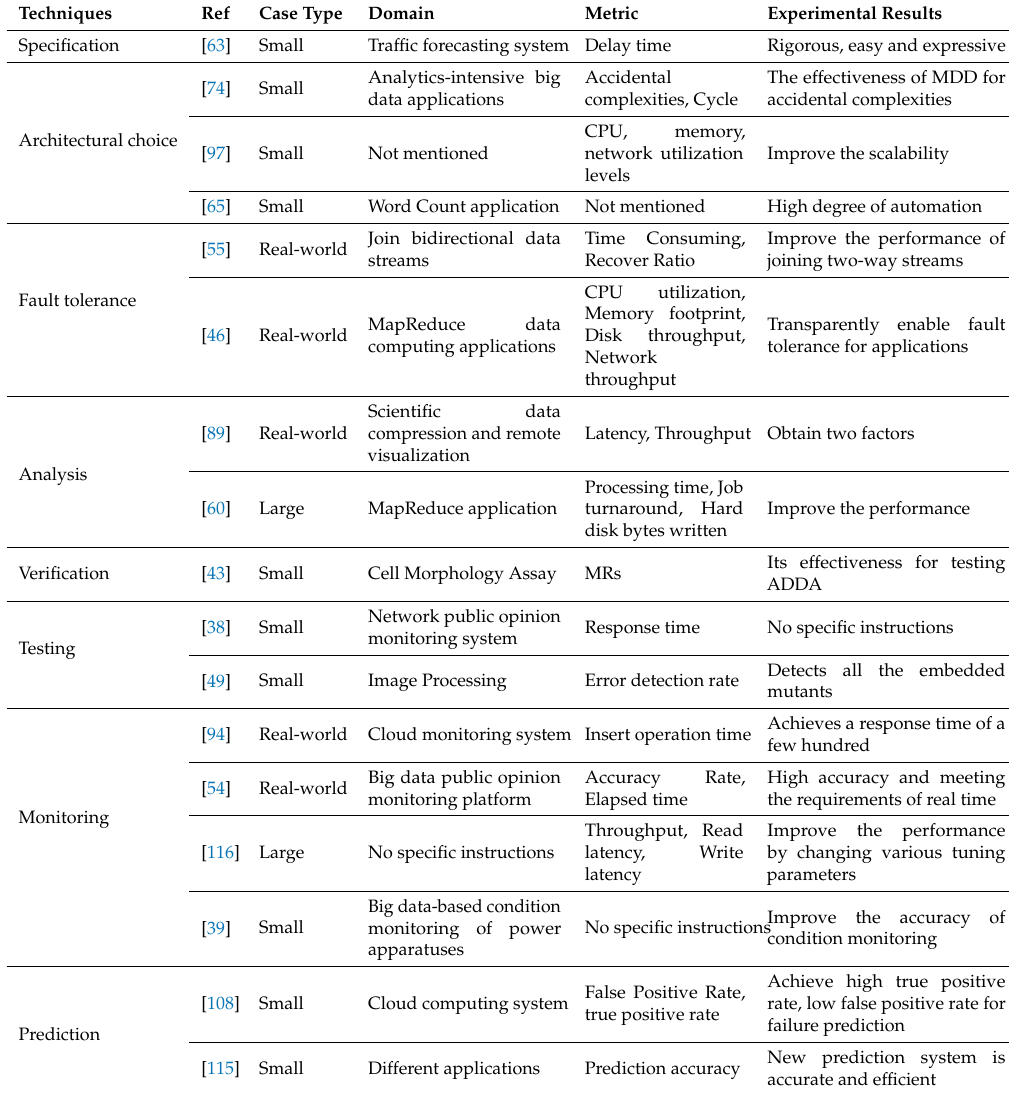
Table 12. Experimental summary and